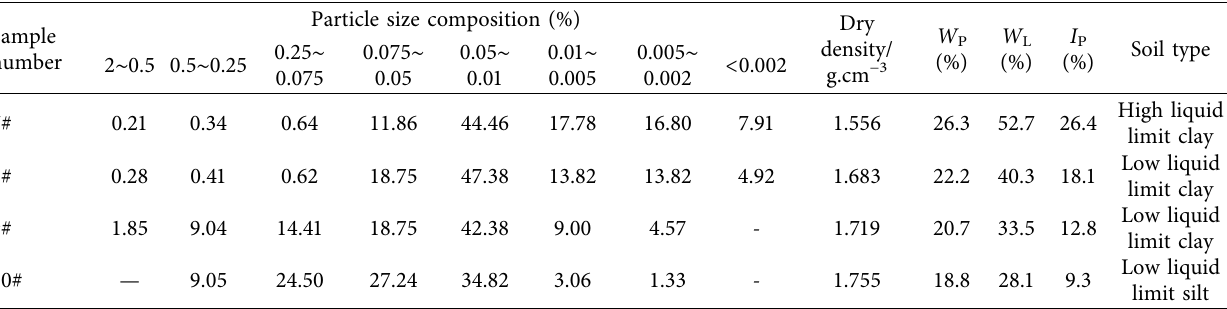
Table 3: The physical indices of the fine-grained soils.